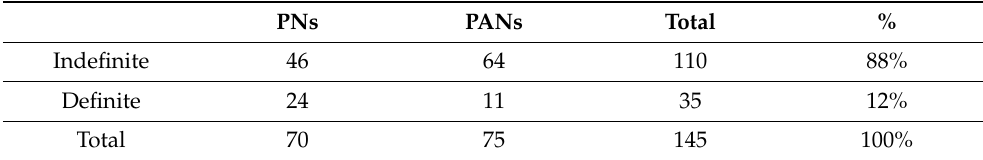
Table 3. Definite and indefinite NPs in PNs and